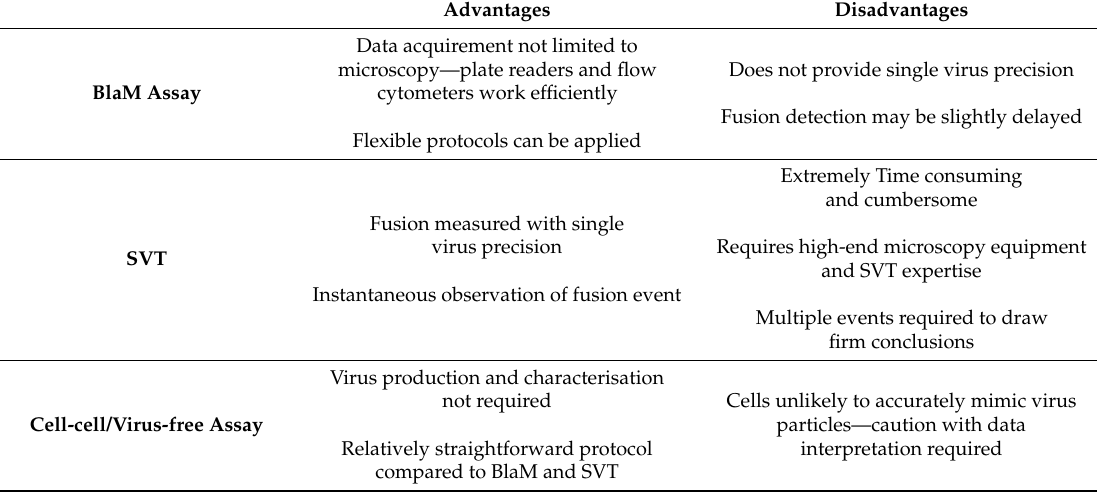
Table 3. A comparison of the benefits and drawbacks of several popular methods used to measure viral